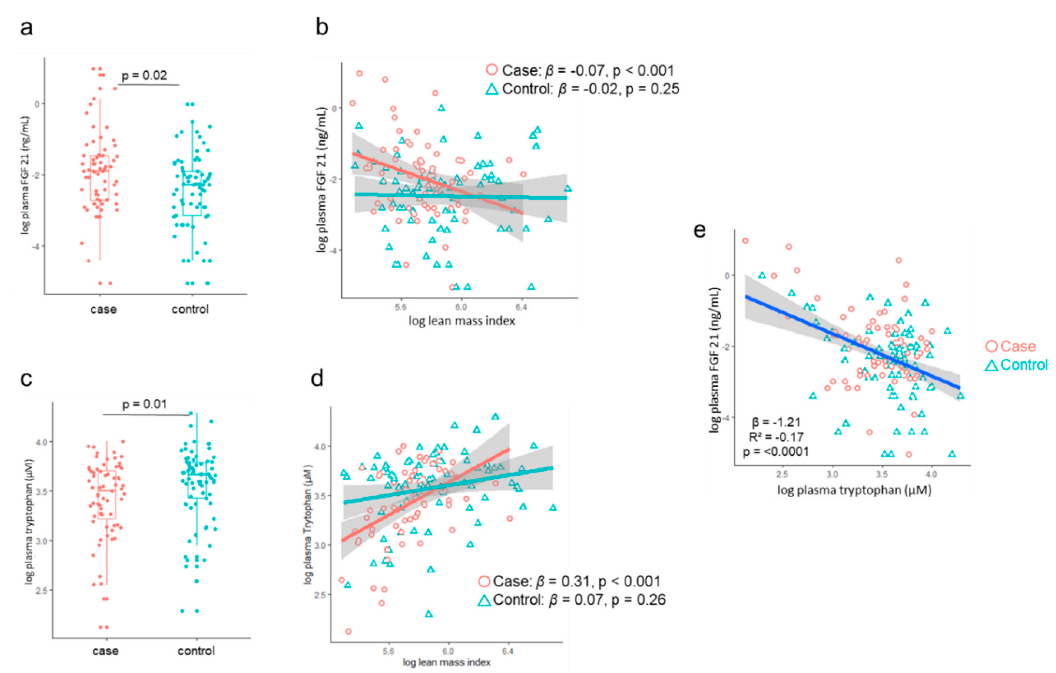
Figure 2. FGF21 and tryptophan levels and their association with lean mass. Concentration differences in plasma FGF21 ( a ) and tryptophan ( c ) in survivors of childhood malnutrition (case) and sibling and community controls in the ChroSAM cohort. Association between lean mass index and FGF21 ( b ) and tryptophan ( d ) stratified by early childhood malnutrition status adjusted for age, sex, and HIV status. The associations between lean and tryptophan ( p interaction = 0.003) and FGF21 ( p interaction = 0.007) were significantly modified by early-life malnutrition. ( e ) Correlation between plasma FGF21 and tryptophan. No evidence of interaction between early malnutrition and the association between FGF21 and tryptophan was found ( p = 0.63).